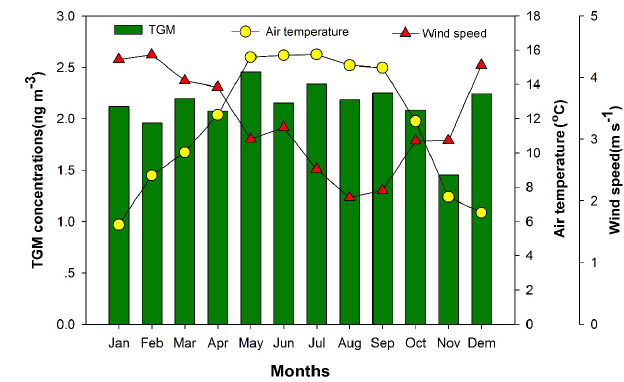
Figure 4. Monthly TGM anomalies at ALS. The Hg concentration during the ISM period (May–September) was higher than that of the non-ISM period (October–April). The highest monthly concen- tration (2.46ngm − 3 ) was observed in May, and the lowest monthly mean concentration (1.45ngm − 3 ) was observed in November. The air temperature was higher, and the wind speed was lower during the ISM period than that of the non-ISM